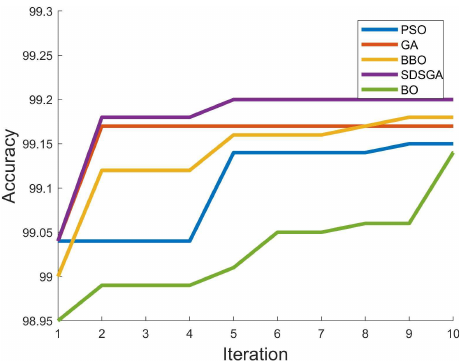
Figure 6. Validation accuracy of CNN model as iteration progresses.